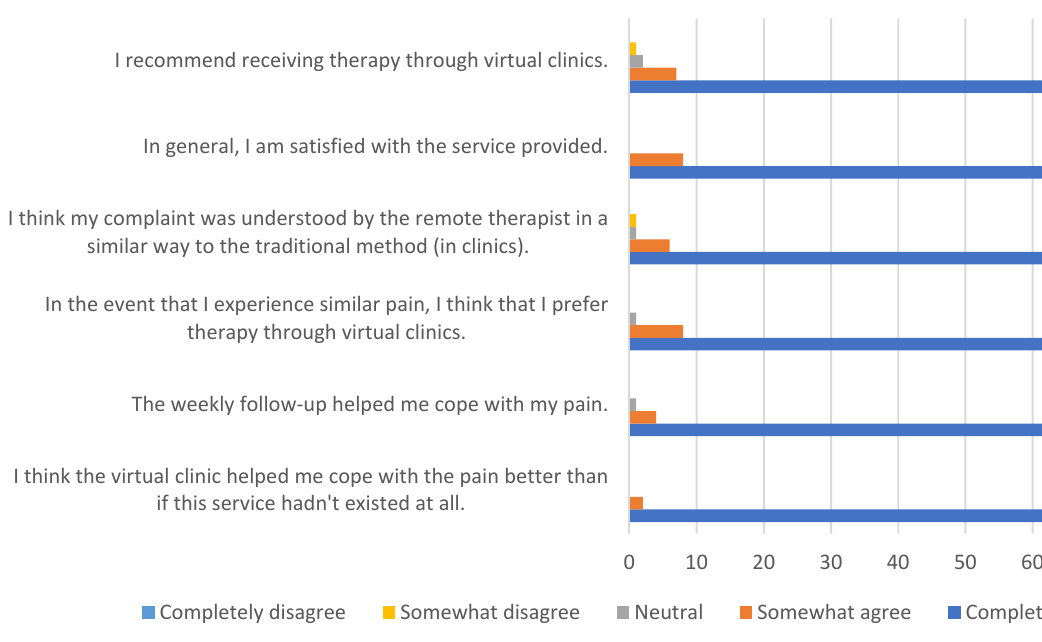
Figure 4. Satisfaction levels related to the telerehabilitation service.